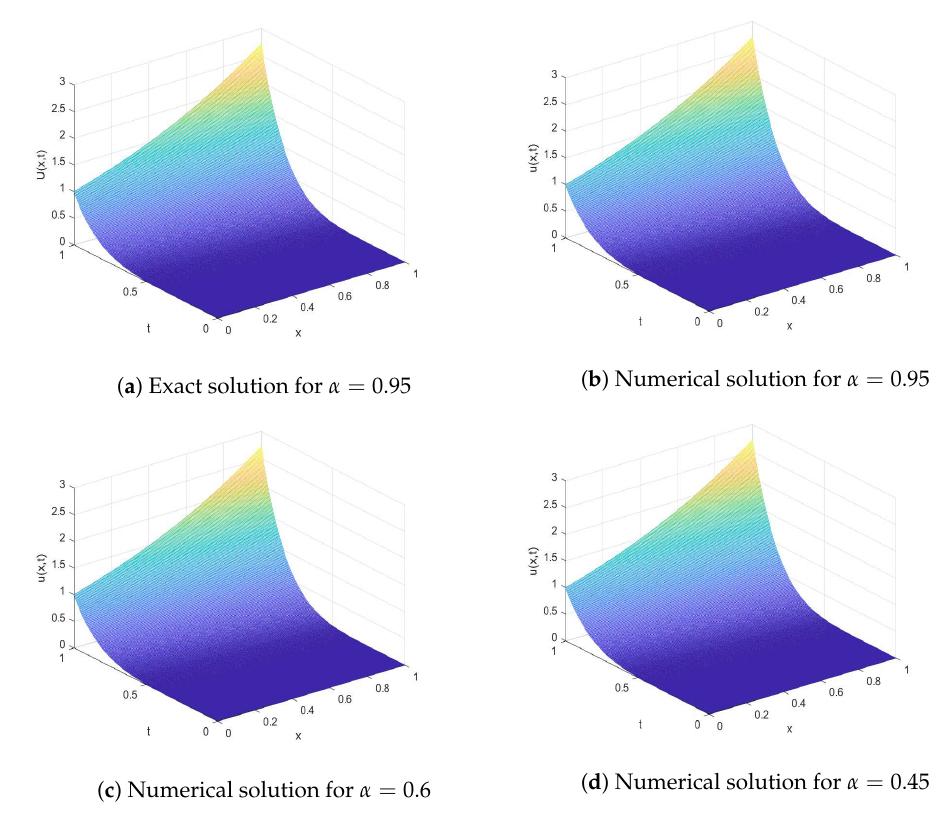
Figure 2. Exact and approximate solutions of Example 2 for different α ’s with M = N = 200, ω ( t ) = 1, ζ ( t ) = t . Table 5. Errors E ∞ and E 2 with convergence rates in time for Example 2, when h = 1/2000 with different α